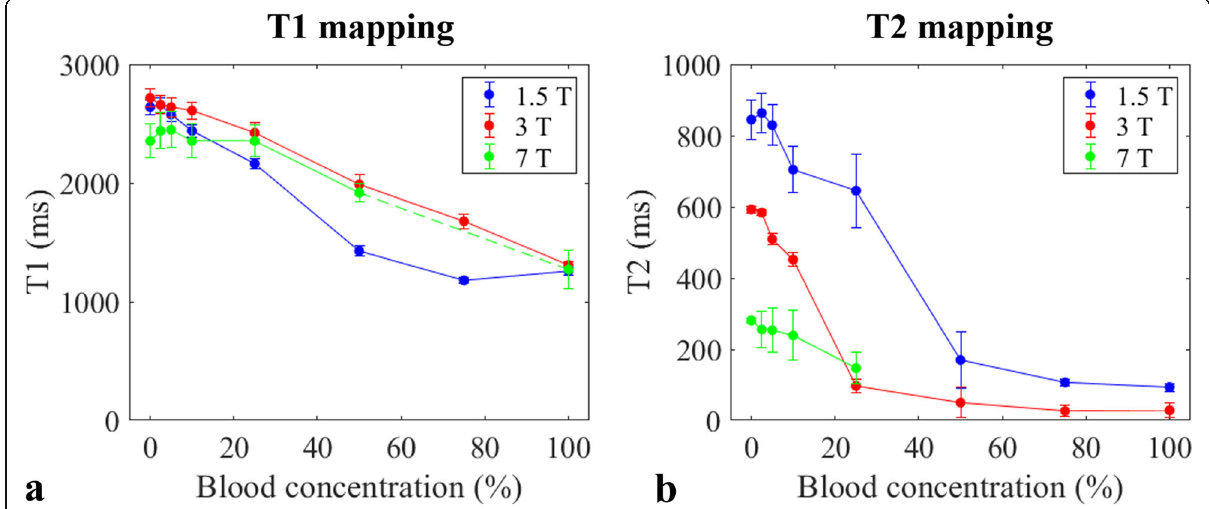
Fig. 2 Mean T1 and T2 value estimates for the different blood concentrations, at 3 field strengths. For 7 T, some of the estimates were not available, because artefacts or relaxation times were too short to be